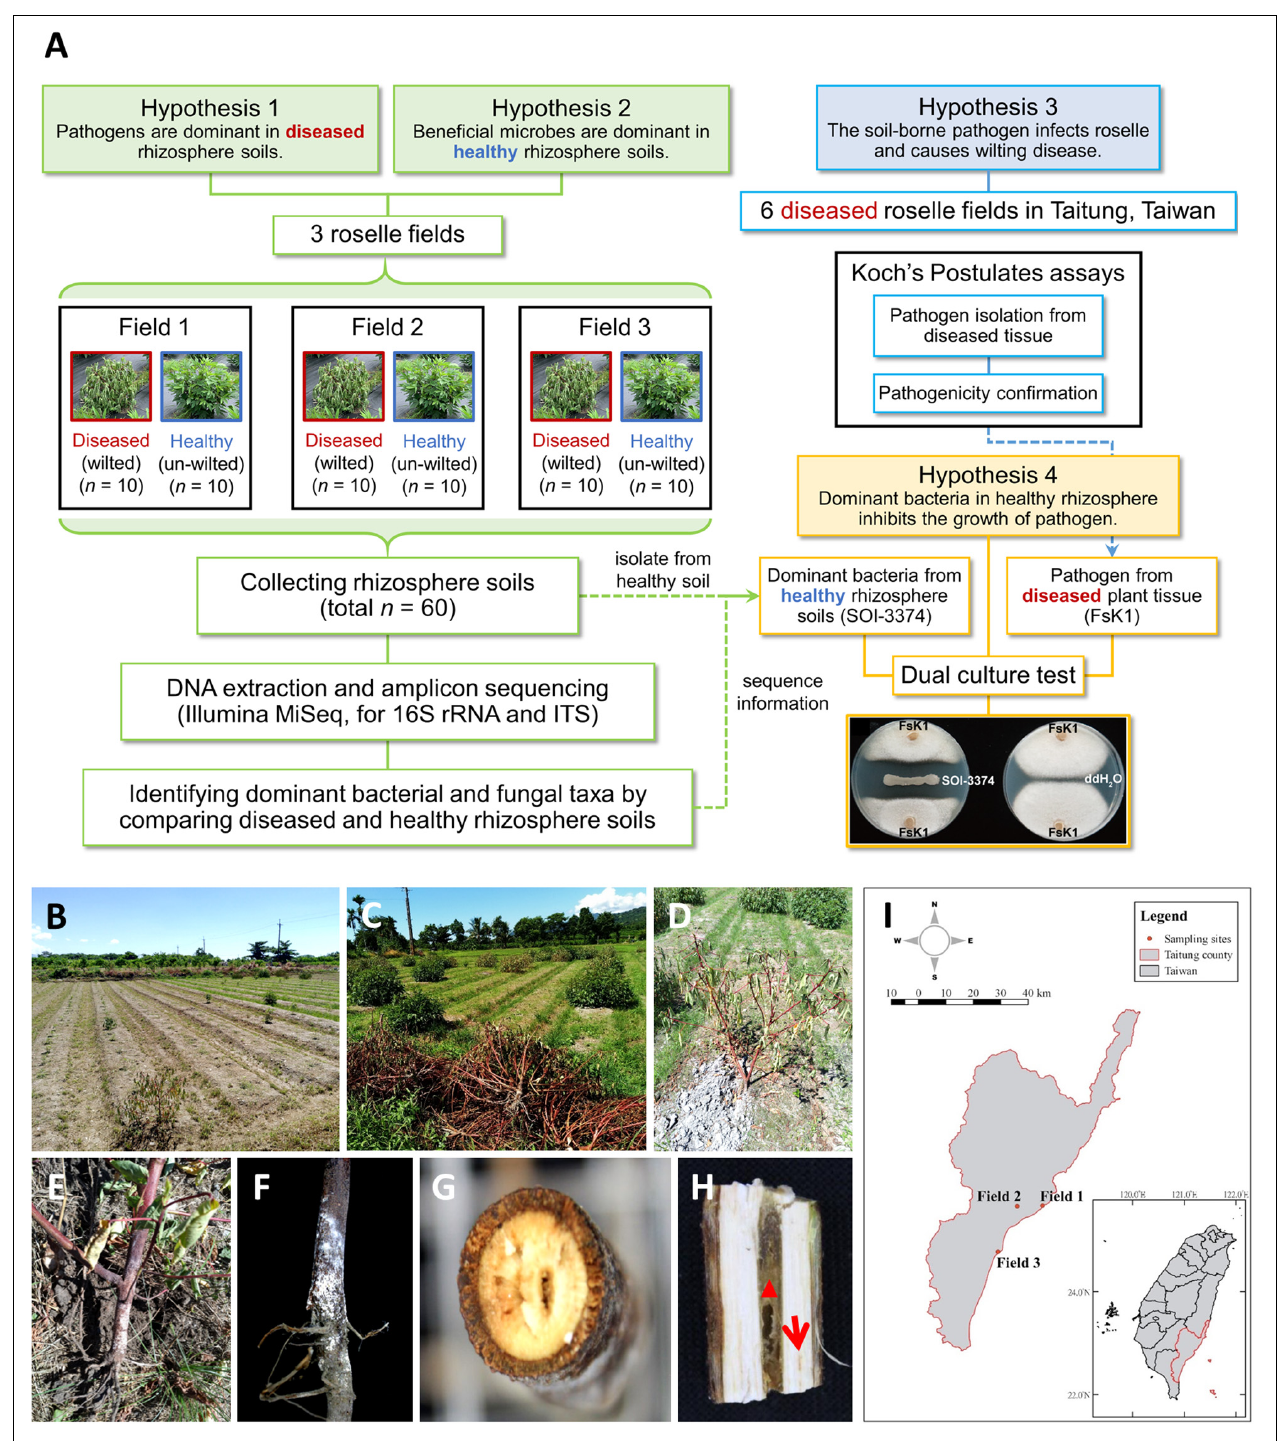
FIGURE 1 | Schematic diagram of this study and the roselle wilt disease and symptoms found in Taitung, Taiwan. (A) A schematic diagram of the hypothesis and methodology. (B) and (C) Roselles were severely damaged by wilt disease. (D) Close-up shot of the wilting symptoms of roselle. (E) and (F) Stem base of wilted roselle colonized by fluffy, cotton-like aerial mycelia and tile mycelia with orange-white color. (G) Cross-section and (H) vertical dissection of diseased stem base, showing that the central pith (red triangle) was browning and rotten, with occasional lightly browning vascular bundles (red arrow). (I) Sampling sites of microbiome study in Taitung City (Field_01), Zhiben (Field_02), and Taimali (Field_03).